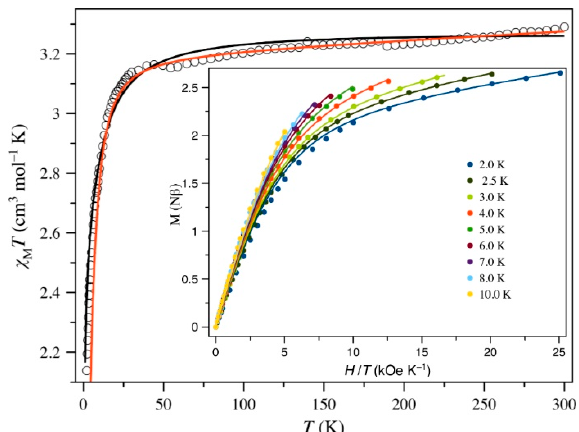
Figure 4. χ M T vs. T and the reduced M vs. H plots (inset) for 2 : (empty and filled circles) experimental; (solid lines) best-fit curves to the experimental data by using the parameters reported in the text for the 1st order SOC (black) and zfs (red) approaches.